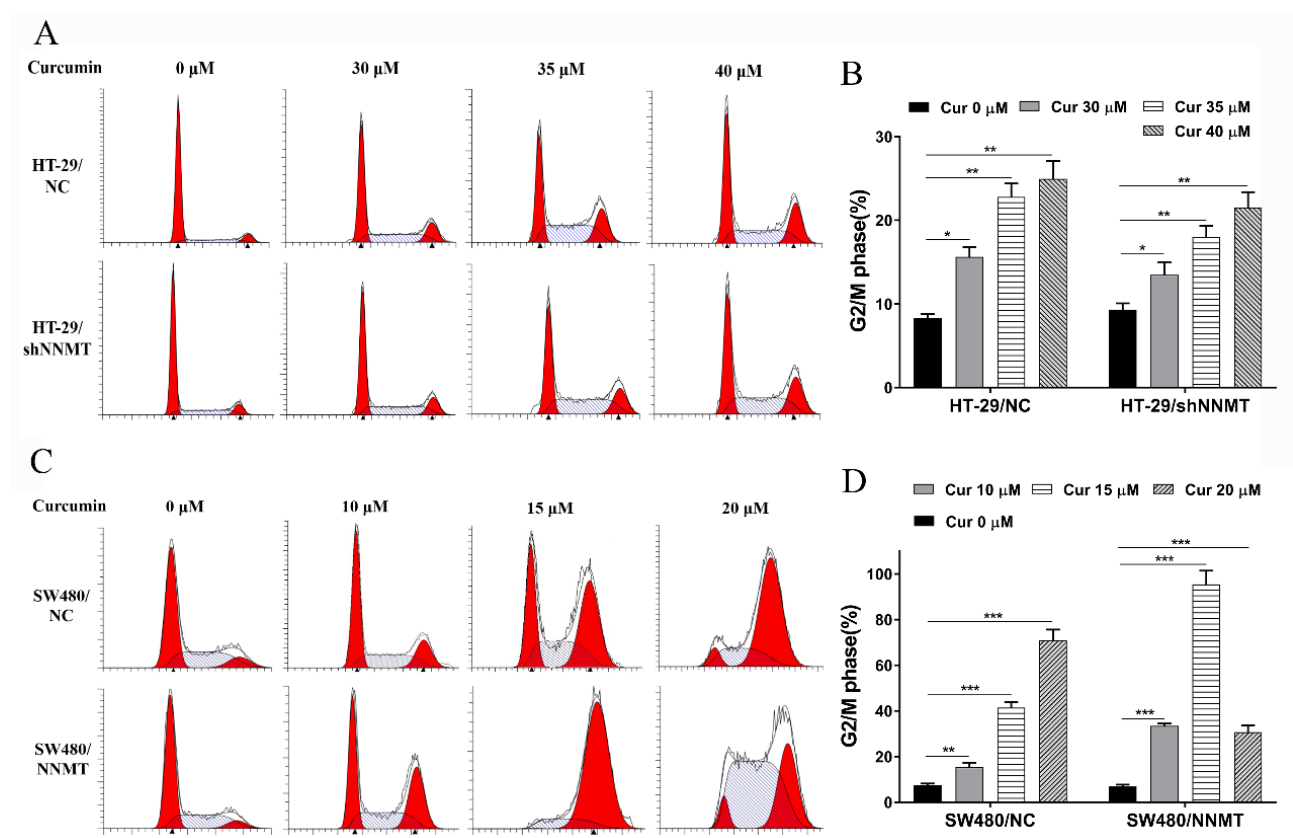
Figure 3. Cur induces cell cycle arrest in a dose-dependent manner in CRC cells. Cells were treated with Cur at different concentrations for 24 h. ( A , B ) Cell cycles were analyzed by flow cytometry and were displayed as a histogram in HT-29 cell lines. ( C , D ) Cell cycles were analyzed by flow cytometry and were displayed as a histogram in SW480 cell lines. Cur: curcumin. Data are expressed as means ± SD, n = 3, * p < 0.05, ** p < 0.01, *** p < 0.001.